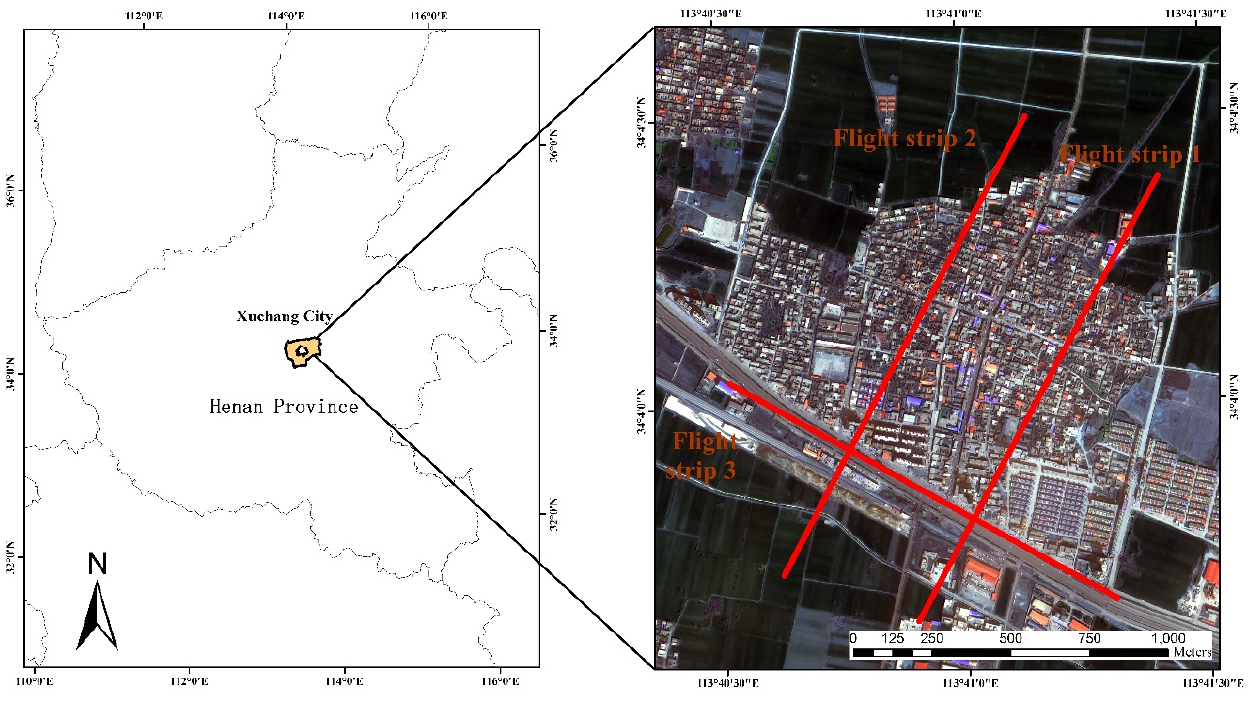
Figure 4. Sampling areas in flight strip 1.